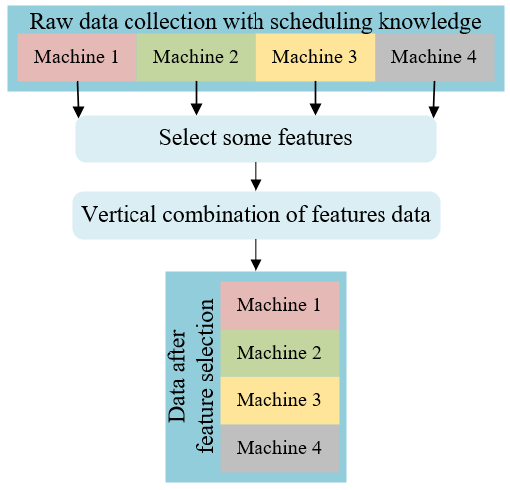
Figure 14 Feature selection process.